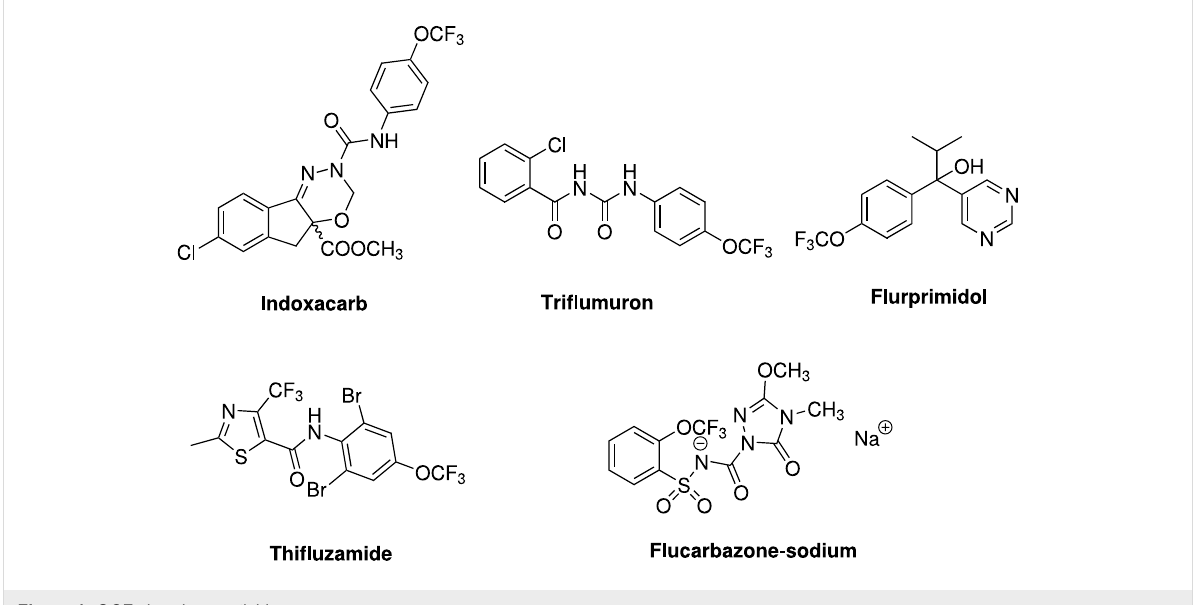
Figure 1: OCF 3 -bearing pesticides.